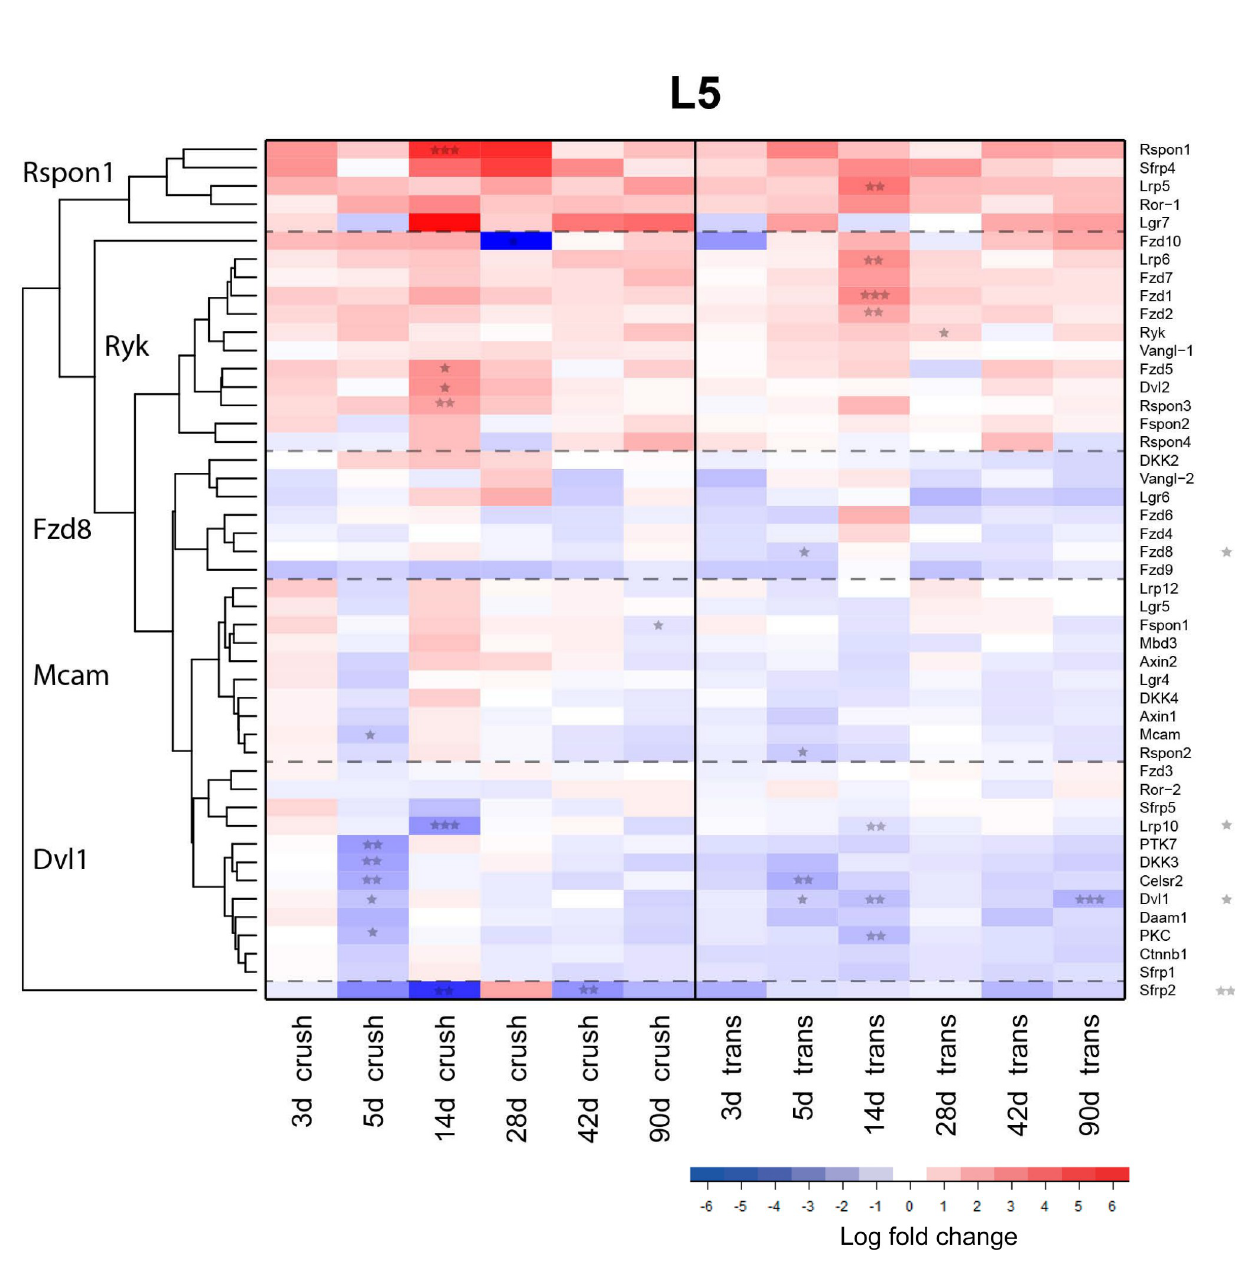
Fig 8. Differential expression of Wnt pathway genes in L5 DRG following sciatic nerve crush or sciatic nerve transection. Wnt-pathway gene expression was analysed in L5 DRG following sciatic nerve crush (left half) or transection (right half). In the heatmap red indicates up-regulation and blue down-regulation compared to control DRG. Five gene clusters, named the R-spondin1, Ryk, Fzd8, Mcam and Dvl1 cluster, were observed. The Ryk cluster contains 7 Wnt receptors, which mostly peak in expression at 14d p.i. All fold changes and SEM are provided in S5 Table. Significant timepoints are indicated by asterisks. Asterisks behind gene names indicate significant effects of injury on the gene expression profile ( � p < 0.05, �� p < 0.01, ��� p < 0.001).